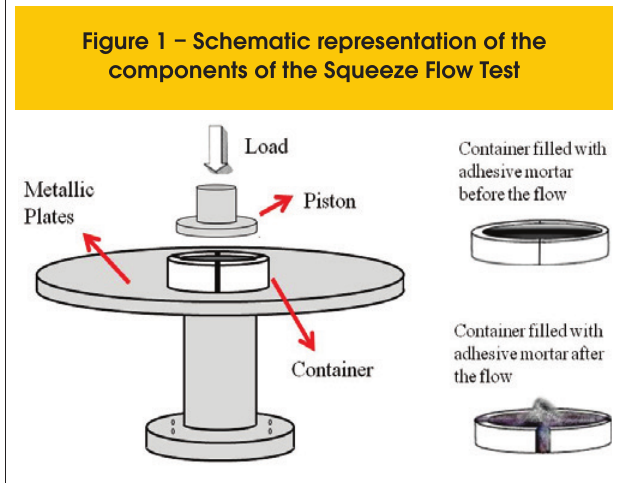
Figure 1 – Schematic representation of the components of the Squeeze Flow